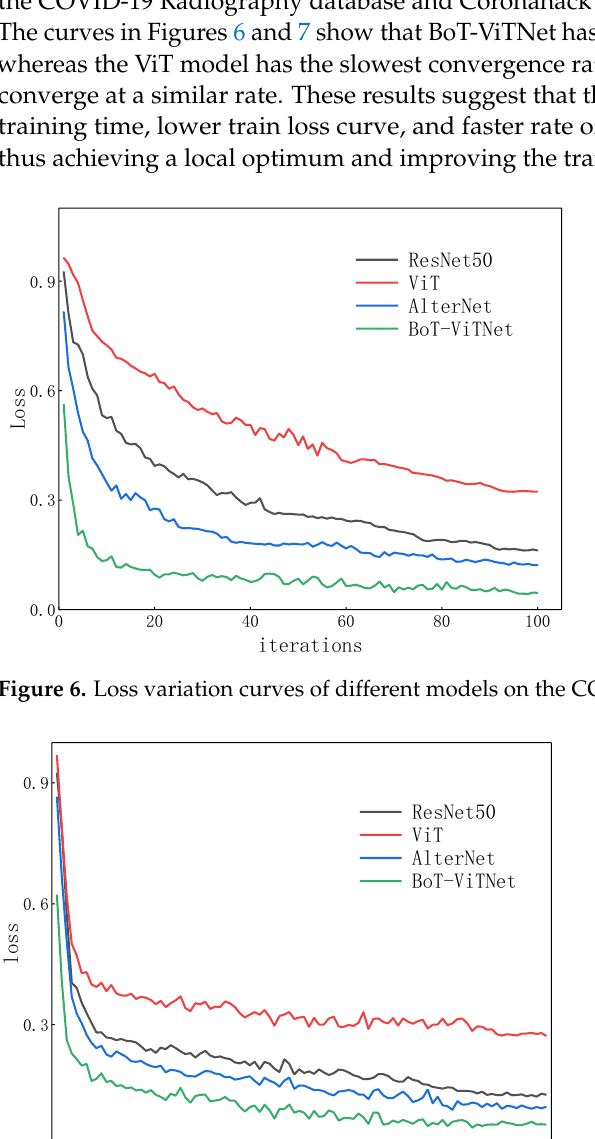
Figure 5. The confusion matrix on the test set of the Coronahack dataset. (a) VGG16; (b) ResNet50;